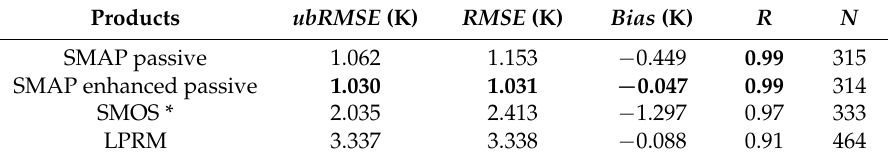
Table 3. Comparison of the SMAP passive, SMAP enhanced passive, SMOS, and LPRM surface temperature ancillary data, with in-situ measurements, for the LWW network region. The ubRMSE, RMSE, and bias are in K, while R is the correlation coefficient ( p -value < 0.01), and N is the number of samples. Bold data in the table represent the best results concerning each error metric.